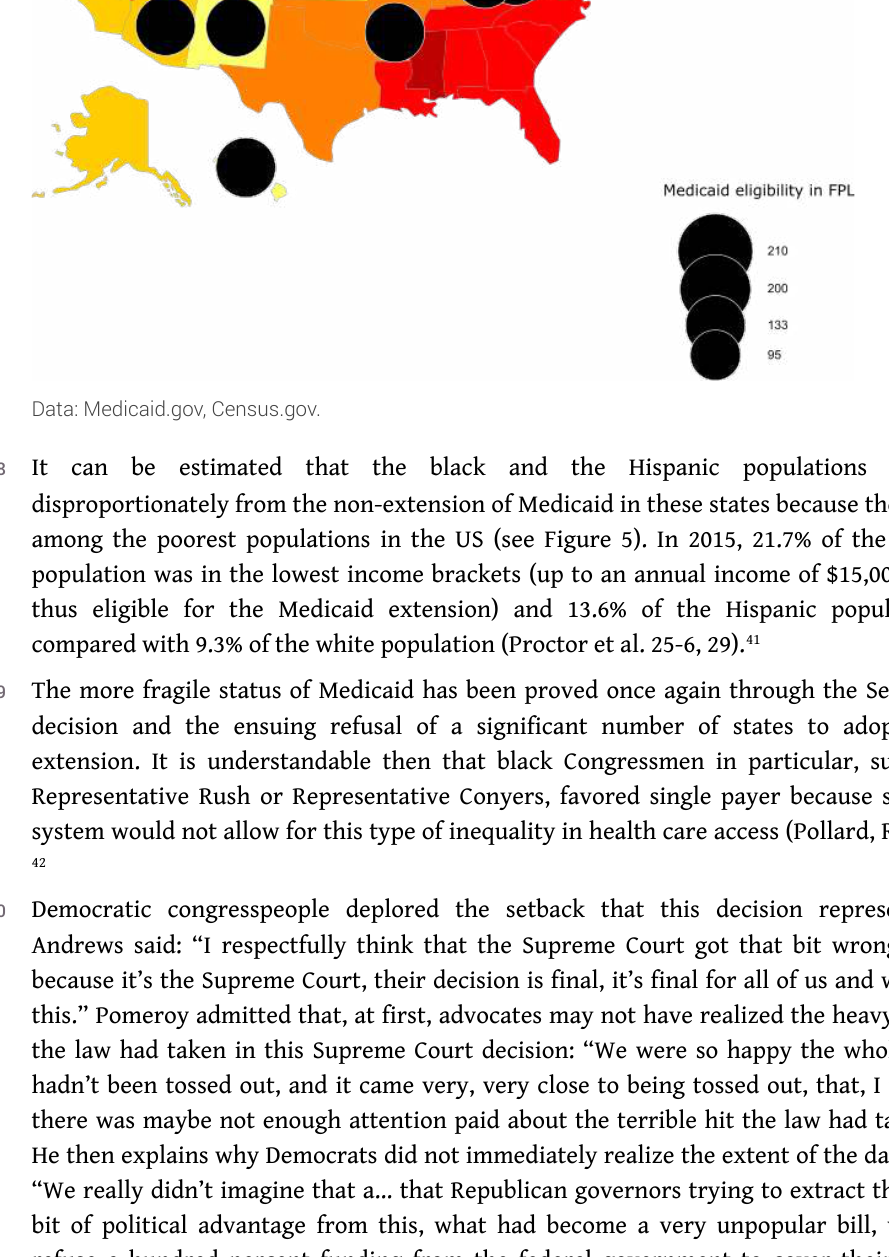
Figure 5. Medicaid eligibility levels for childless adults and density of the black population by state, in percent, 2014